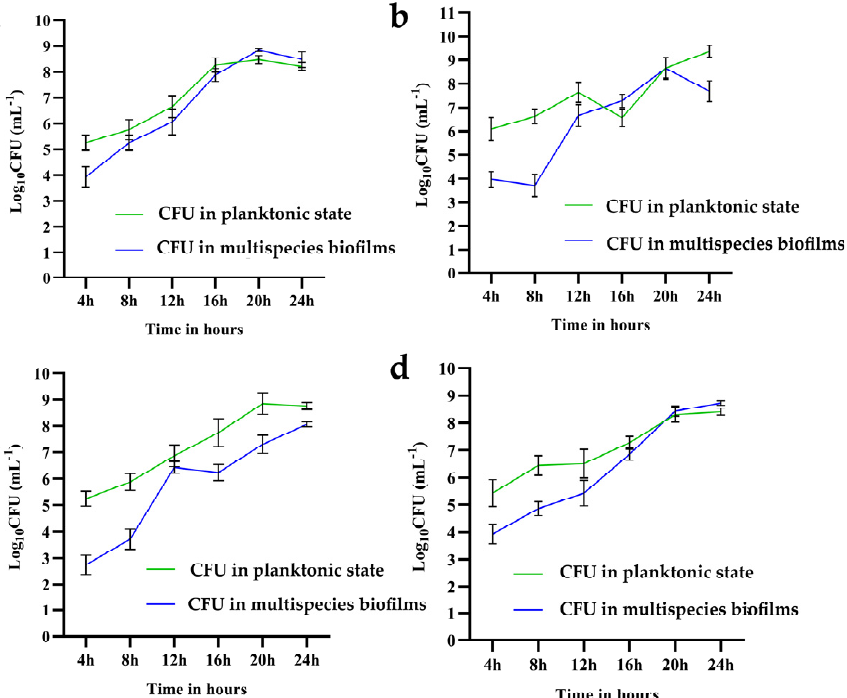
Figure 4. Cell count of the four species in suspension and mixed-species biofilms. ( a ) B. longum FJND16M4, ( b ) E. faecalis E1, ( c ) B. ovatus FTJS5K9, and ( d ) L. gasseri FHNFQ11L7. The green line represents the cell number of each species in suspension and the blue line represents the number of each species in mixed-species biofilms. The number of cells was measured every four hours and error bars in the line chart represent the mean value of biological replicates ± SD.